Question: Provide a one-line summary of what is displayed.
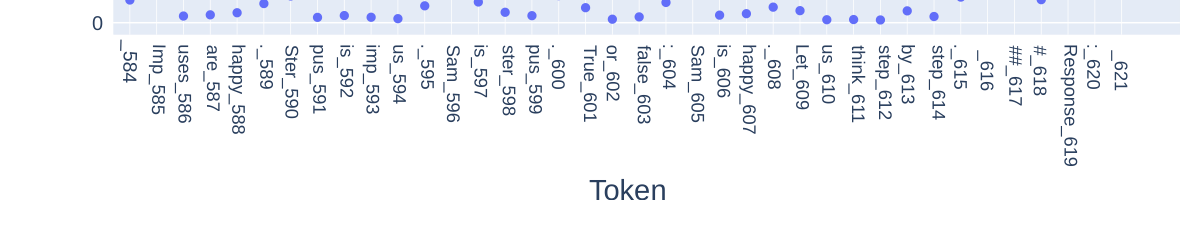
Answer: Average attention probability distribution (across all heads) over question context in an example subtask 0. Here, the model needs to predict the token Sam.